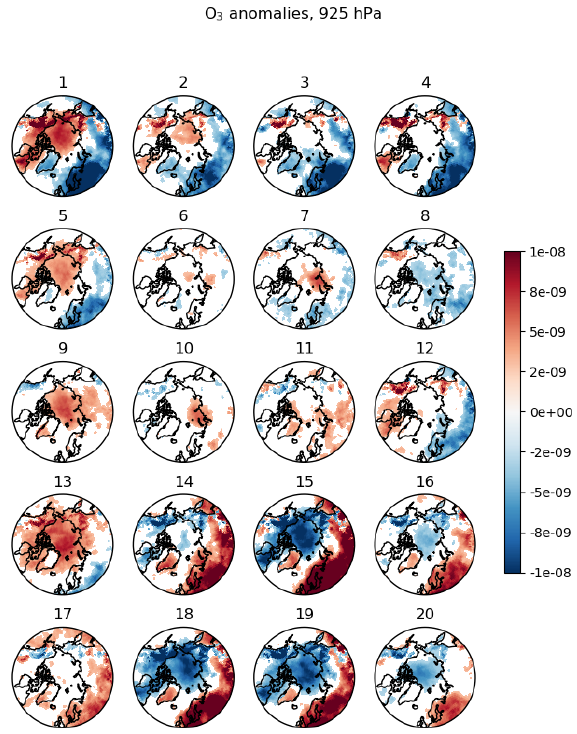
Figure A5. The 925hPa O 3 anomalies as volume mixing ratios based on CAMS data for the 20 circulation types. Only those anomalies that are statistically significant at the 90% confidence level are